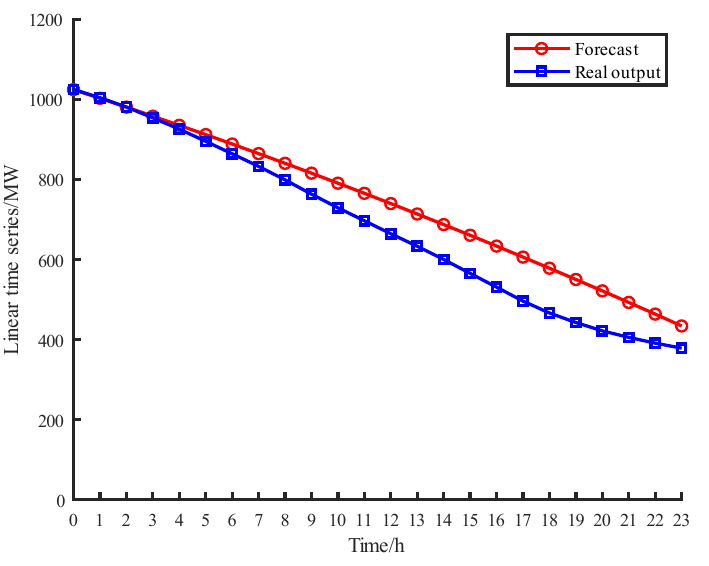
Table 4. Parameter of ARIMA model. Figure 3. Iteration curve of fitness. Figure 3. Iteration curve of fitness.